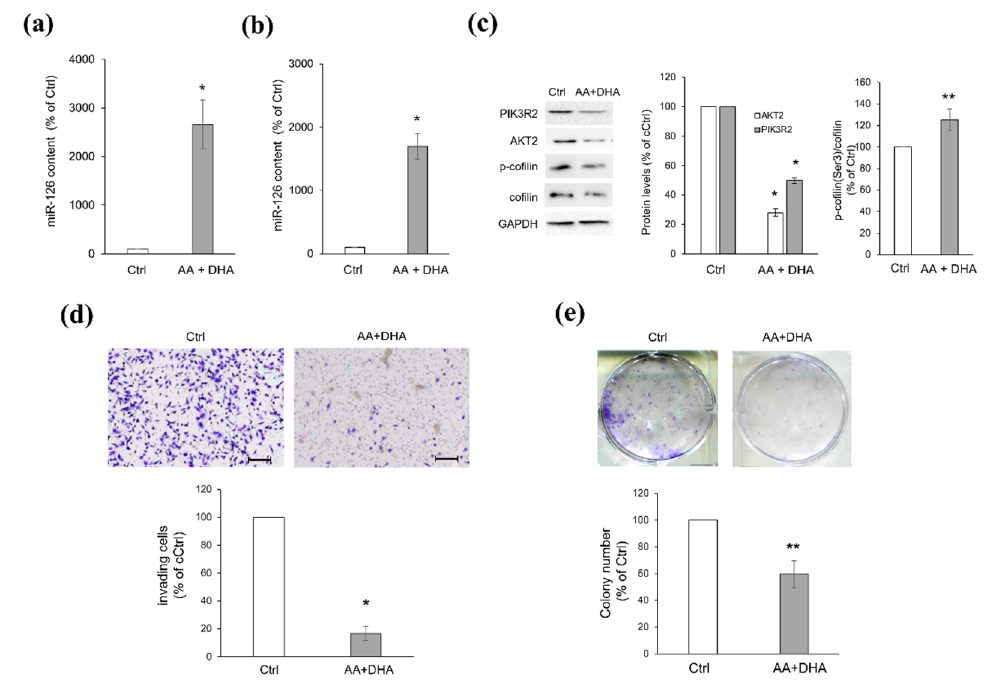
Figure 6. miR-126-3p-enriched MVs derived from PUFA-treated platelets decrease tumorigenic properties of BT549 cells by directly targeting AKT2. ( a ) RT-PCR analysis of miR-126 content in MVs derived from resting (Ctrl) or AA plus DHA-treated (AA + DHA) platelets and ( b ) in BT549 cells after MV delivery. Histograms show miR-126 expression reported as percentage of relative Ctrl, arbitrarily set to 100%. ( c ) Western blot analysis of PIK3R2, AKT2, and phosphorylated cofilin levels in BT549 cells treated as in ( b ). Blots are representative of four independent experiments. Histograms represent the densitometric analysis, expressed as percentage of Ctrl, arbitrarily set to 100%. ( d ) Transwell invasion assay performed with BT549 cells treated as in ( b ). Images are representative of three independent experiments. Histogram shows the number of invading cells, reported as percentage of Ctrl, arbitrarily set to 100% (absolute cell number = 284 ± 17.24). ( e ) CFU assay performed with BT549 cells treated as in ( b ). Photographs are representative of three independent experiments. Histograms show colony number reported as percentage of Ctrl arbitrarily set to 100% (absolute colony number = 162.27 ± 4.3). Data in histograms are shown as mean ± SEM. * p < 0.01 and ** p < 0.05 versus relative Ctrl. Scale bars: 250 µm.